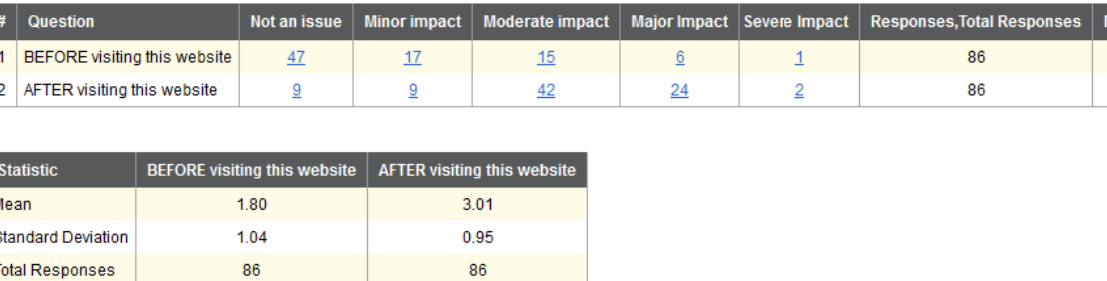
Figure 5. The responses to Question 30: What was your opinion on the impact of